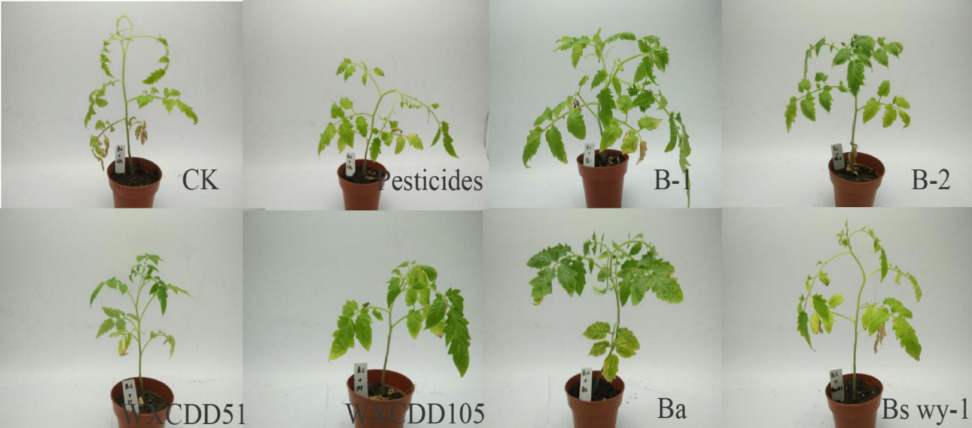
Figure 6. Therapeutic effects of single and complex strains on tomato seedlings infected with gray mold. Polyoxin is an antibiotic that can effectively prevent leaf mold. In the treatment test of tomato leaf mold, the incidence and disease index of the chemical pesticide 10% polyoxin treatment were the lowest, 28.22% and 12.96, respectively, and the curative effect was 71.54%. The morbidity and disease index of the strain combination F-1 were 30.35% and 9.48, respectively, which were 37.03% and 79.22% less than the water control, and the curative effect was 79.09%. The morbidity and disease index of the strain combination F-2 were 30.21% and 9.31, respectively, which were 37.32% and 79.59% less than the water control, and the curative effect was 79.56%. Thus, the treatment effects of the two combinations are stronger than each single strain and chemical pesticides (Figure 7).